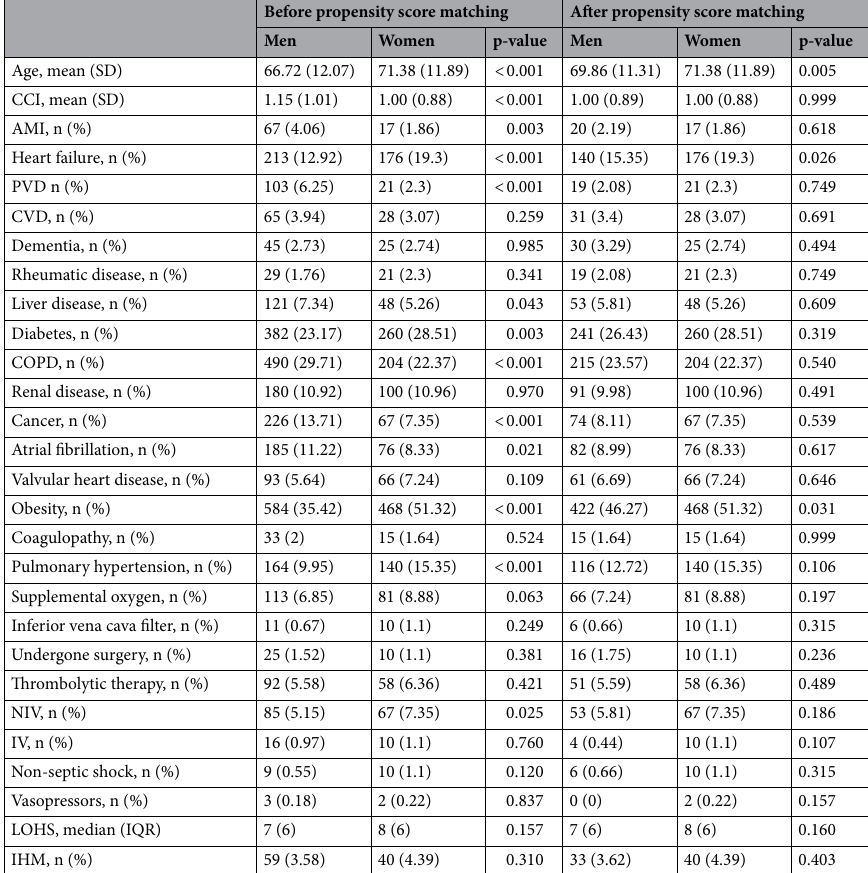
Table 4. Prevalence of specific comorbid conditions, therapeutic procedures, and hospital outcomes in men and women hospitalized with pulmonary embolism (PE) and obstructive sleep apnea in Spain from 2016 to 2018 before and after propensity score matching. OSA Obstructive sleep apnea, CCI Charlson comorbidity index, AMI acute myocardial infarction, PVD peripheral vascular disease, CVD cerebrovascular disease, COPD chronic obstructive pulmonary disease, NIV non-invasive ventilation, IV invasive ventilation, LOHS length of hospital stay, IHM in-hospital mortality, SD standard deviation, IQR Inter quartile range. p value for comparison of men and women with OSA.